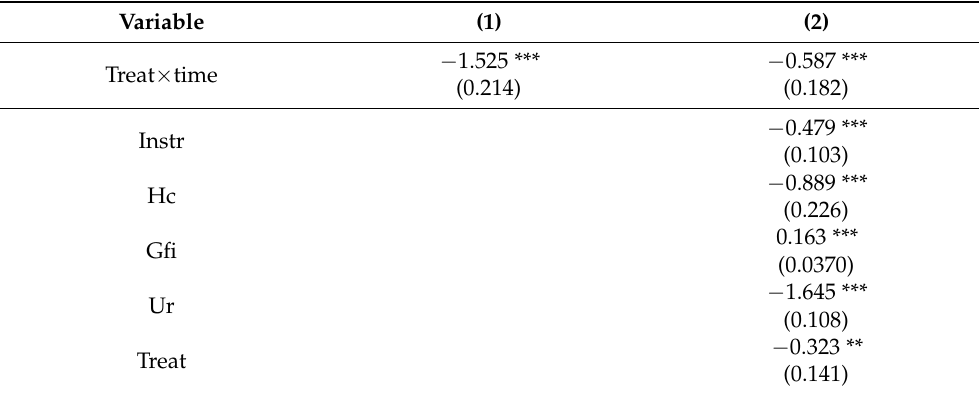
Table 9. Baseline